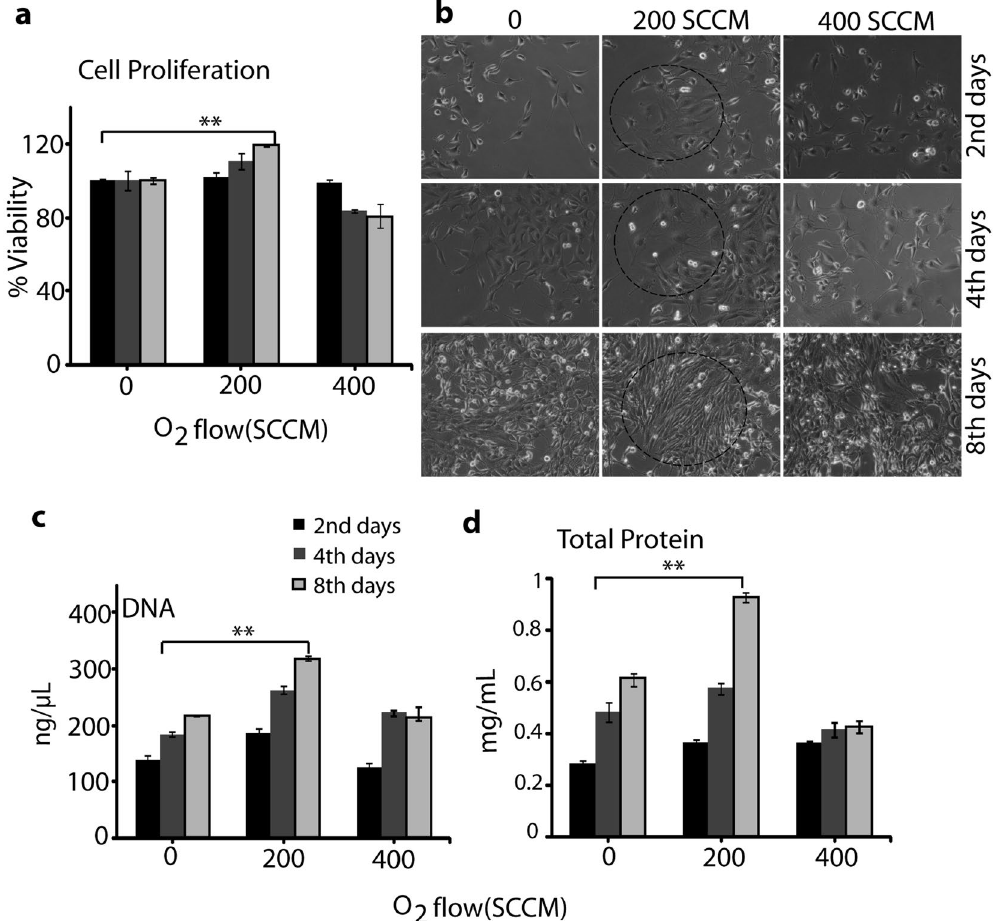
Figure 3. L6 muscle cells proliferation, differentiation, DNA, and total protein content analysis after NO exposure. ( a ) Cell proliferation analysis, ( b ) Cell differentiation analysis using light microscopy, ( c ) DNA estimation, and ( d ) Total protein measurement after exposure with NO (200 and 400 SCCM of O 2 flow rate) for 3 min day 2, day 4, and day 8. All values are expressed as ± SD in triplicate. Students t-test was performed as the control ( * denotes P < 0.05 and ** denotes P <